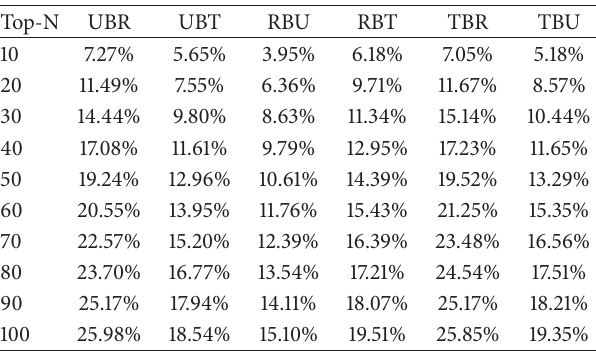
Table 4: Recall of the six algorithms.